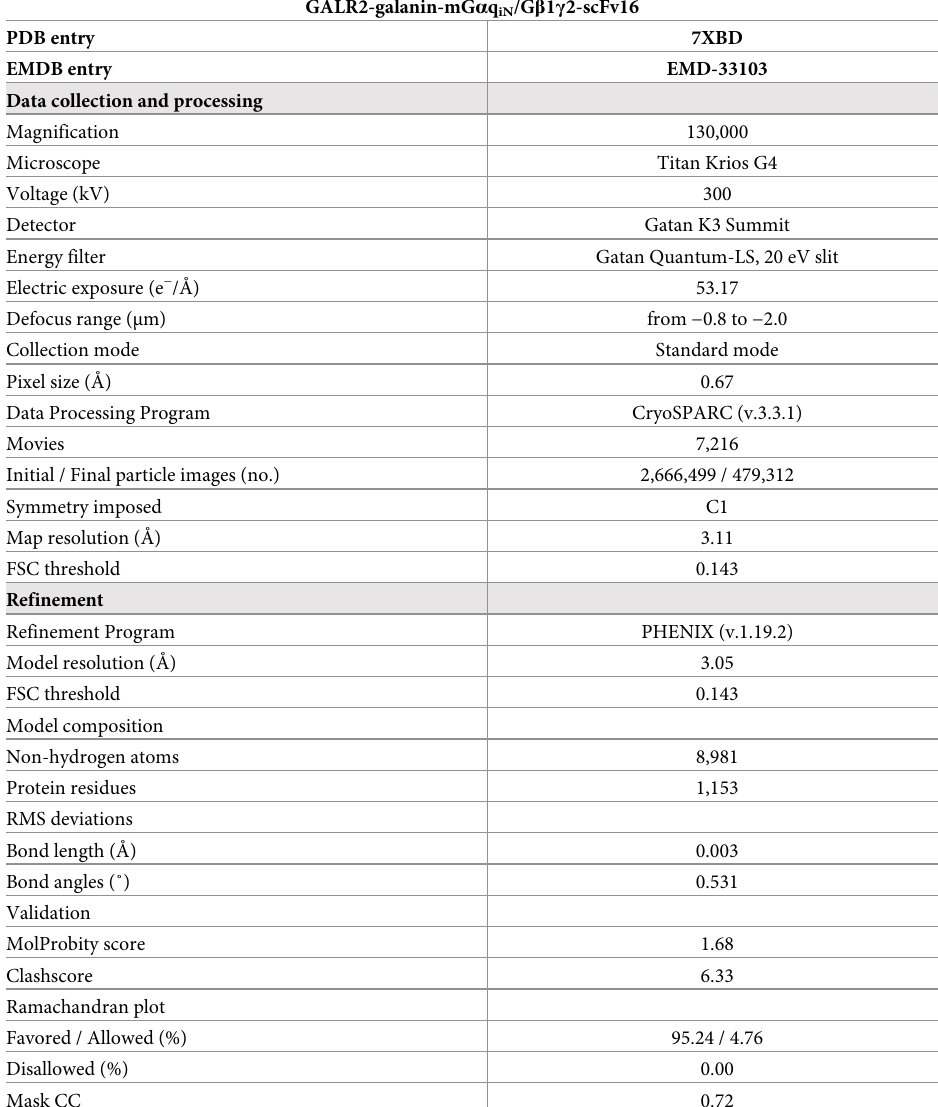
Table 1. Cryo-EM data collection, refinement, and validation